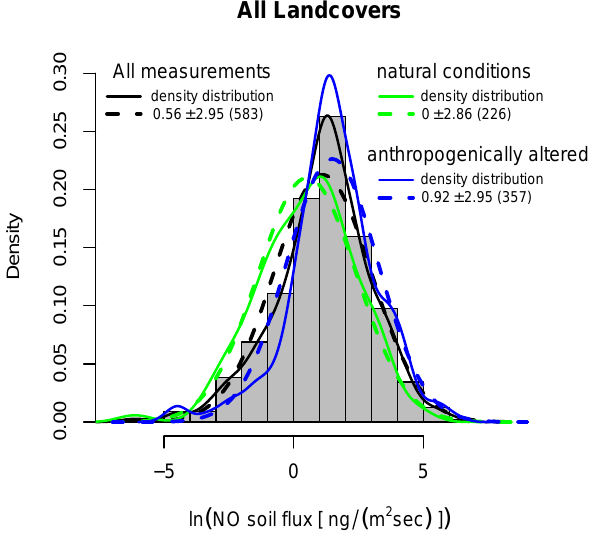
Fig. 2. Logarithmic histogram and probability density function (solid line) of all measured SNO x in the compilation with stan- dard distribution, calculated mean and standard deviation. Black lines: all measurements, green lines: under natural conditions only, blue lines: anthropogenically altered only. The dashed lines are the calculated standard distributions. Number of measurements are in